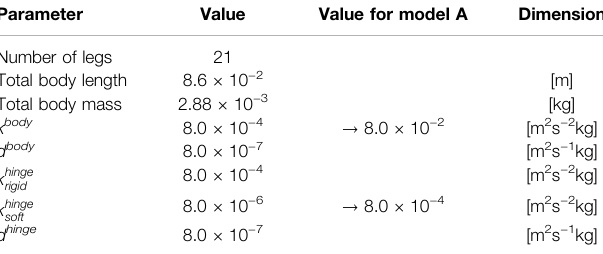
denotes the ground i